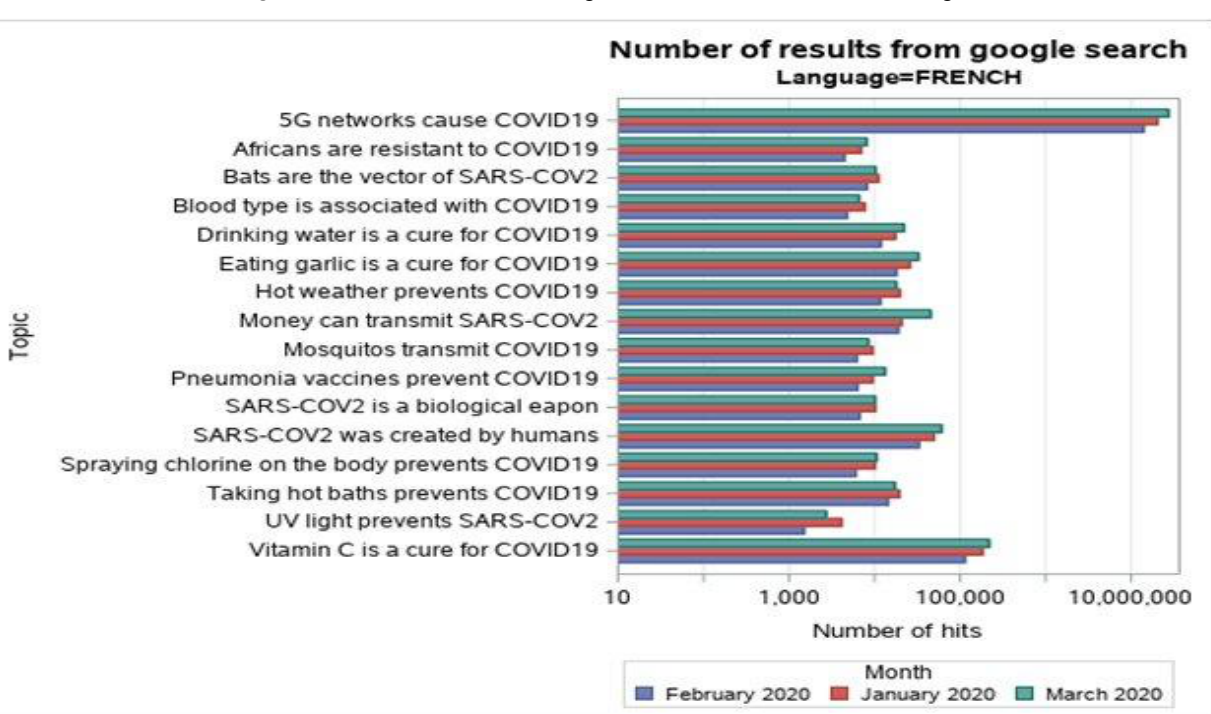
Figure 2: Number of results from Google search in French. UV: Ultraviolet light